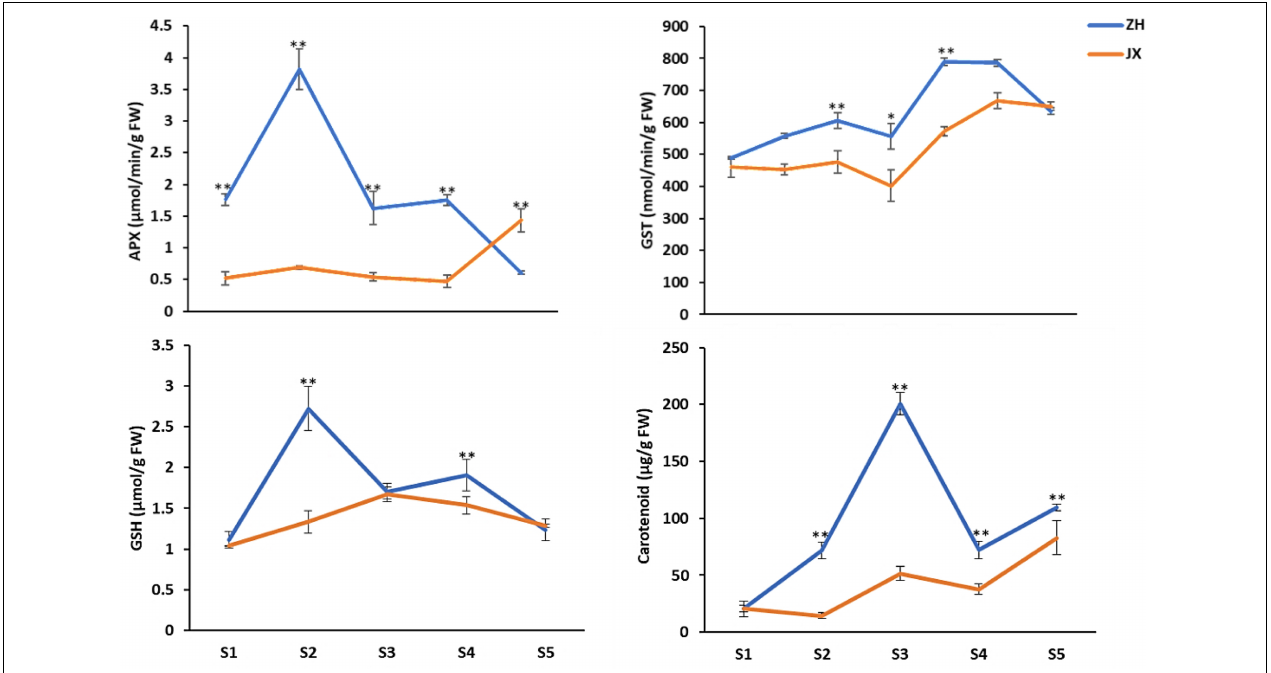
FIGURE 8 | Content of antioxidants in the anthers of “ZH” and “JX” at stages 1–5. Error bars indicate ± SD of three biological replicates. Statically significant differences at P ≤ 0.05 and P ≤ 0.01 (Student t test) are indicated by ∗ and ∗∗ ,